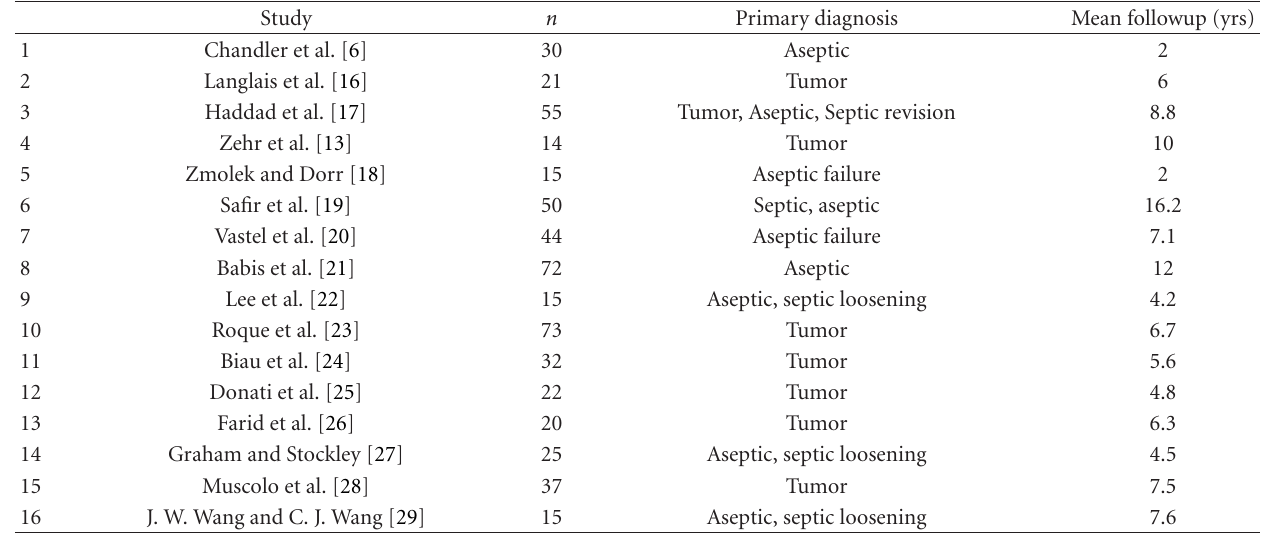
Table 1: Sixteen studies using allograft prosthetic composite in the treatment of proximal femoral bone loss, number of patients per study, primary diagnosis, and mean followup.